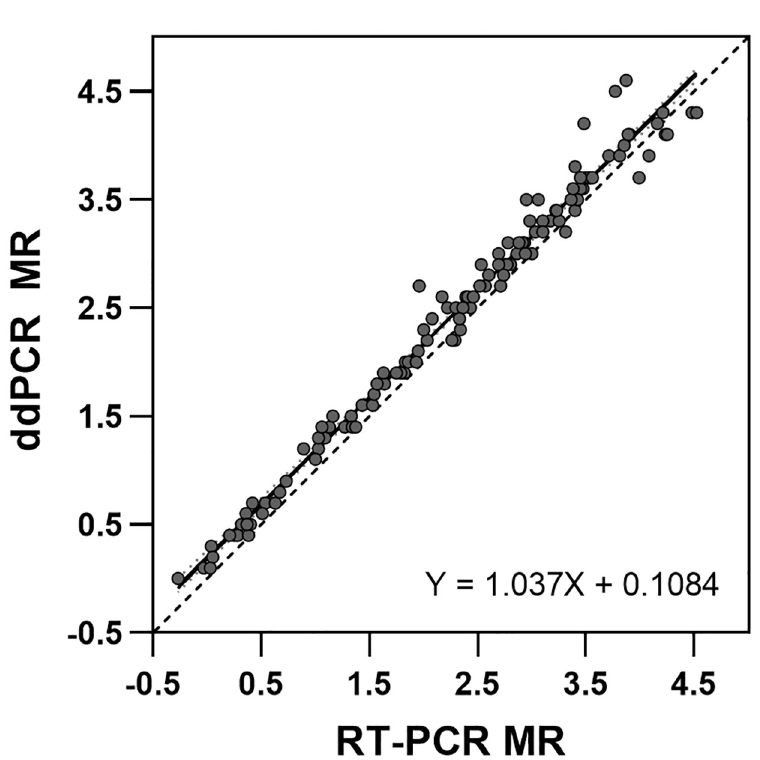
Fig 6. Deming regression analysis of clinical method comparison. Correlation between ddPCR and RT-PCR on 139 evaluable paired samples (solid grey circles). The linear fit is the solid black line, and the identity is the dashed black